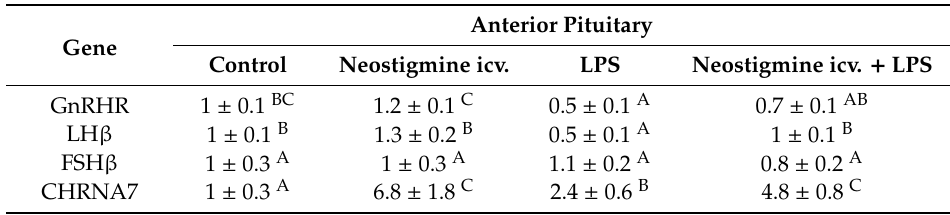
Table 3. E ff ect of lipopolysaccharide (LPS; 400 ng / kg; intravenous) and neostigmine (1 mg / animal; intracerebroventricular (icv.)) administrations on the relative mRNA expression (mean ±